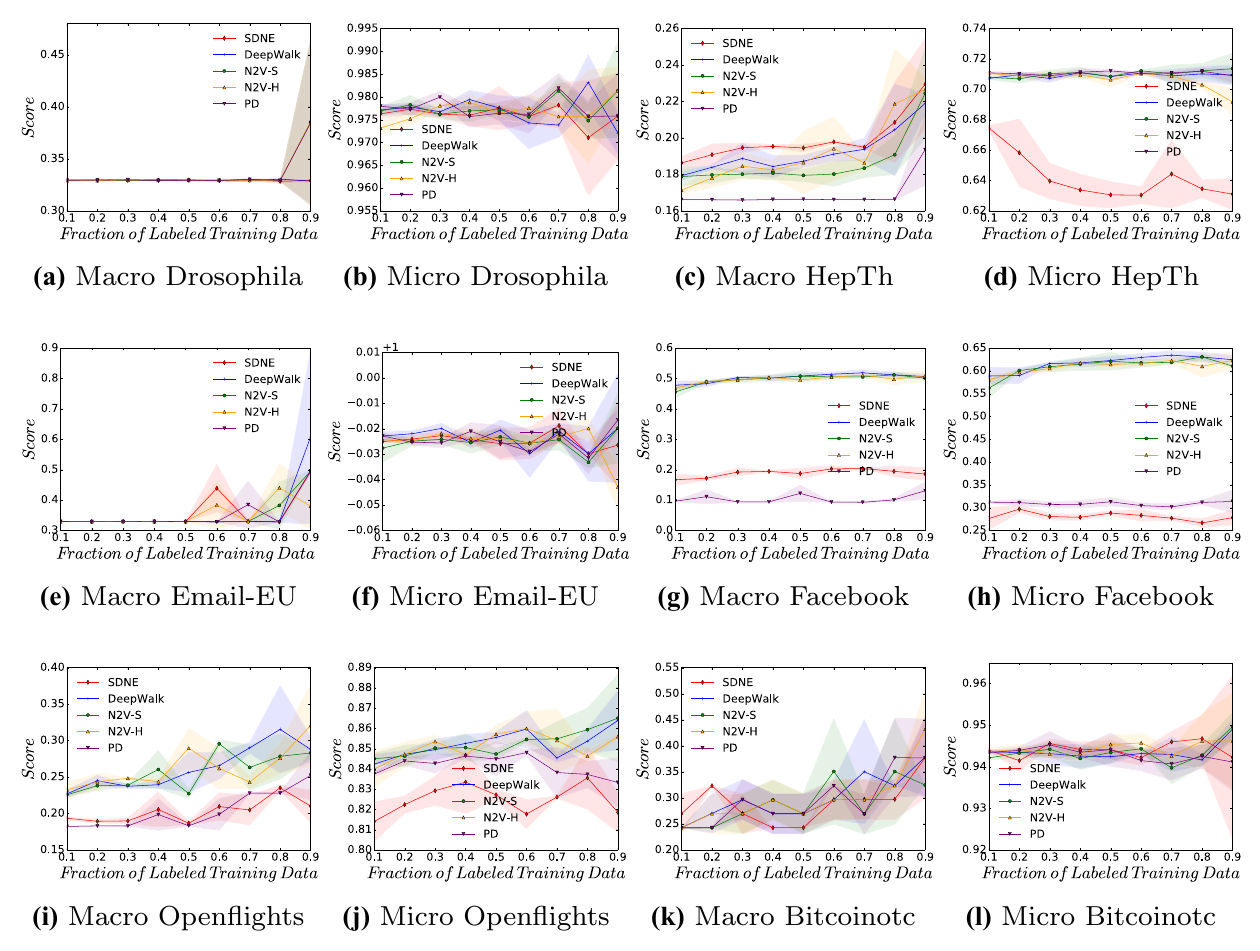
Fig. 6 Micro-f1 and macro-f1 scores, across a range of labelling fractions, for all approaches when predicting a vertex’s eigenvector centrality (EC) value across all